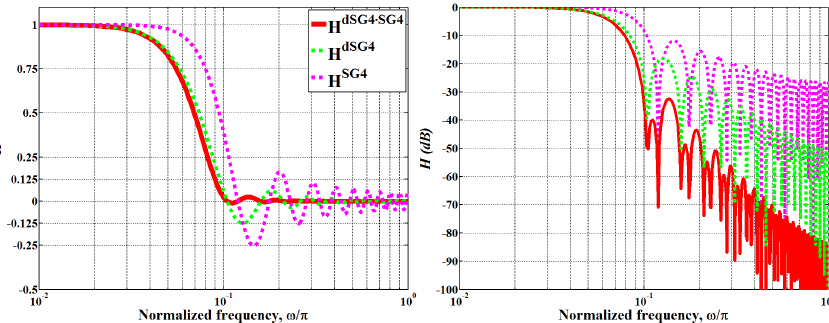
Figure B2. Left plot: example of the dSG4 · SG4 cascade (both with N = 20) showing low-amplitude side lobes while preserving the pass- band extension of the dSG4 filter. H ≈ 1 for 0 <ω/π< 10 − 2 . Right plot: same frequency responses plotted in decibel